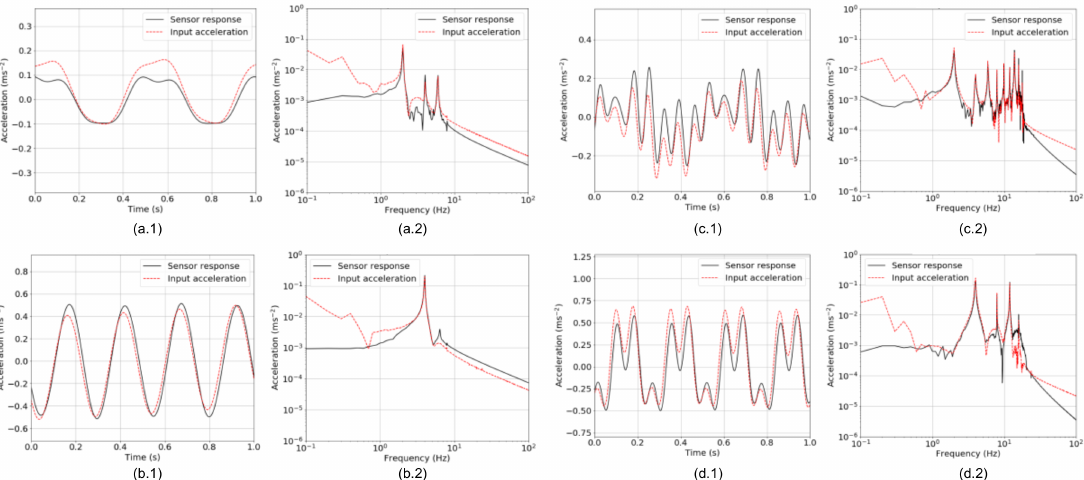
Figure 7. Profiles of responses of the proposed accelerometer and input vibration in (x.1) time domain and (x.2) frequency domain: ( a ) 2-Hz vibration applied to the proposed accelerometer in Pattern 2; ( b ) 4-Hz vibration to the accelerometer in Pattern 2; ( c ) 2-Hz vibration to the accelerometer in Pattern 3; and ( d ) 4-Hz vibration to the accelerometer in Pattern